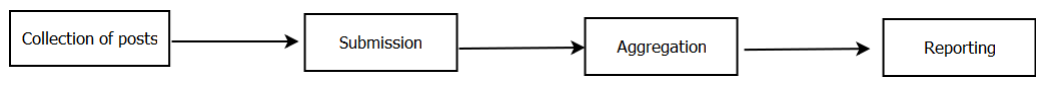
Figure 5. Experimentation